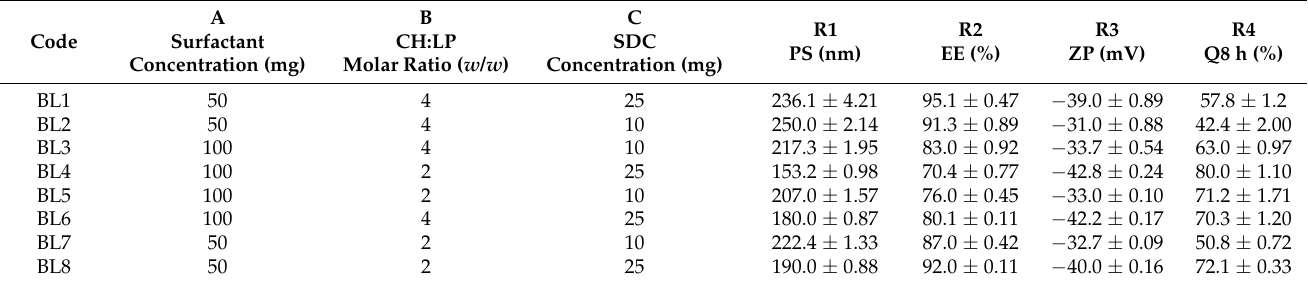
Table 2. Composition and dependent variables for the developed LT-loaded bilosome